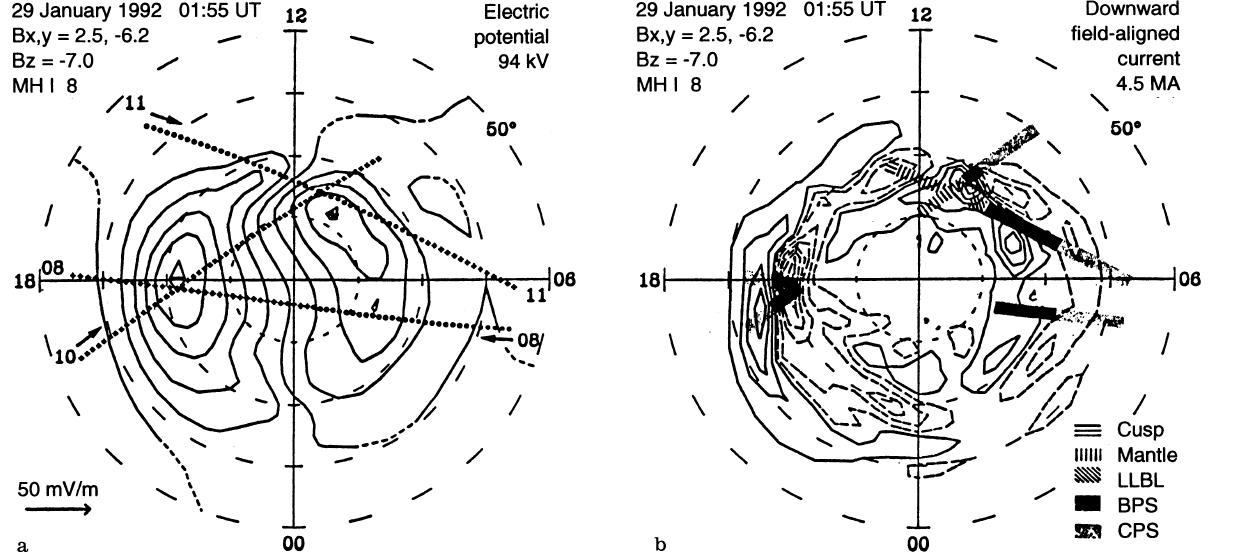
Fig. 2 a. The ionospheric convection pattern derived at 0155 UT on January 29, 1992, in the Northern Hemisphere. The pattern has a contour interval of 10 kV. The satellite trajectories which have been converted to apex coordinates are indicated as either dots (if the observations were made prior to 0155 UT) or plus signs (if they were made after 0155 UT). The solid arrows show the direction of the satellite motion. b Distribution of the field-aligned current density,